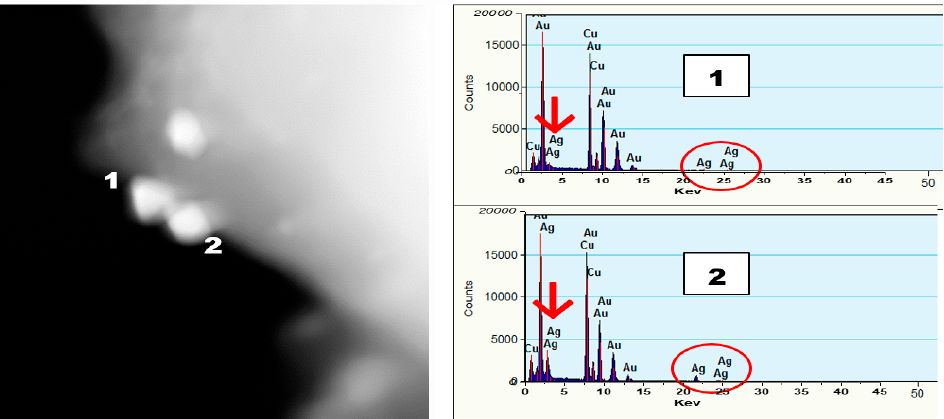
Figure 7. STEM images and EDS spectra for large bimetallic Au-Ag nanotwins. Left: Spot analysis images. Right: EDS spectra. Table 1. Diameter of large Au-Ag nanotwins determined from TEM images after 15 min and 30 min of irradiation. For non-spherical particles, the longest dimension refers to the length of the particle considered for the size measurements herein.